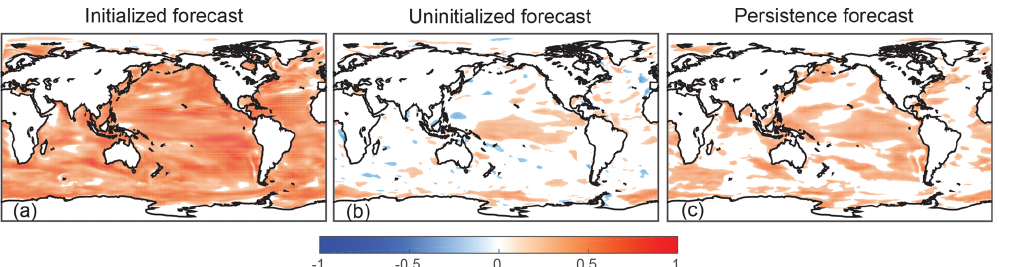
Figure 4. Predictability of air–sea CO 2 flux, as indicated by the correlation coefficient of detrended air–sea CO 2 flux anomalies from the (a) CESM-DPLE initialized forecast lead year 1 with the reconstruction and the (b) CESM-LE uninitialized forecast with the reconstruction. (c) Correlation coefficient of the persistence forecast for lead year 1. Correlation coefficients that are not statistically significant at the 95% level using a t test are assigned a value of